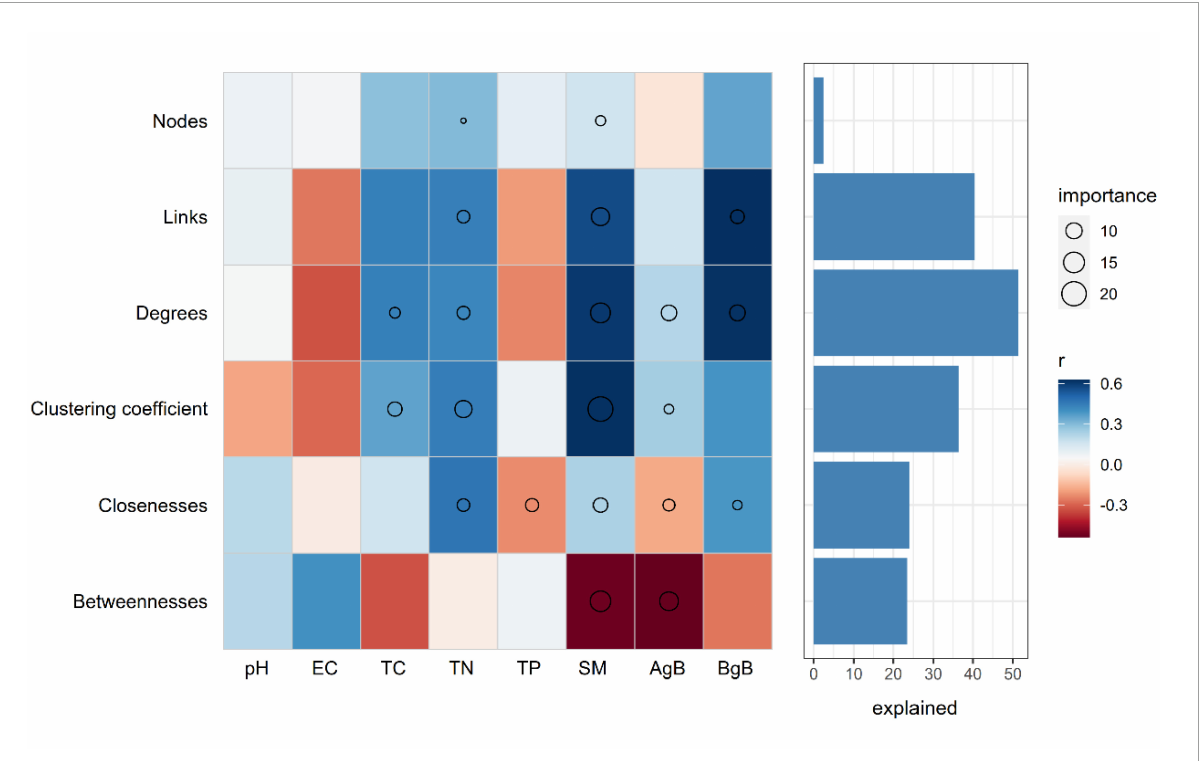
FIGURE5 Potential contributions of the soil properties and plant aboveground and belowground biomass to the dissimilarities of network topological features. Circle ( P < 0.05) size represents variable importance (i.e., the proportion of explained variation calculated via multiple regression modeling and variance decomposition analysis). Colors represent Spearman correlations. EC, elecstrical conductivity; TC, soil total carbon; TN, soil total nitrogen; TP, soil total phosphorus; SM, soil moisture; AgB, aboveground biomass; BgB, belowground